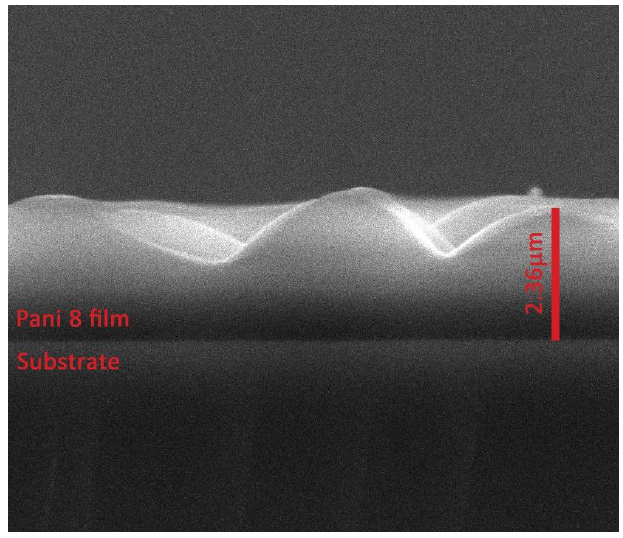
Figure 5. SEM images of the transversal cross-section of the PANI 8 sample.